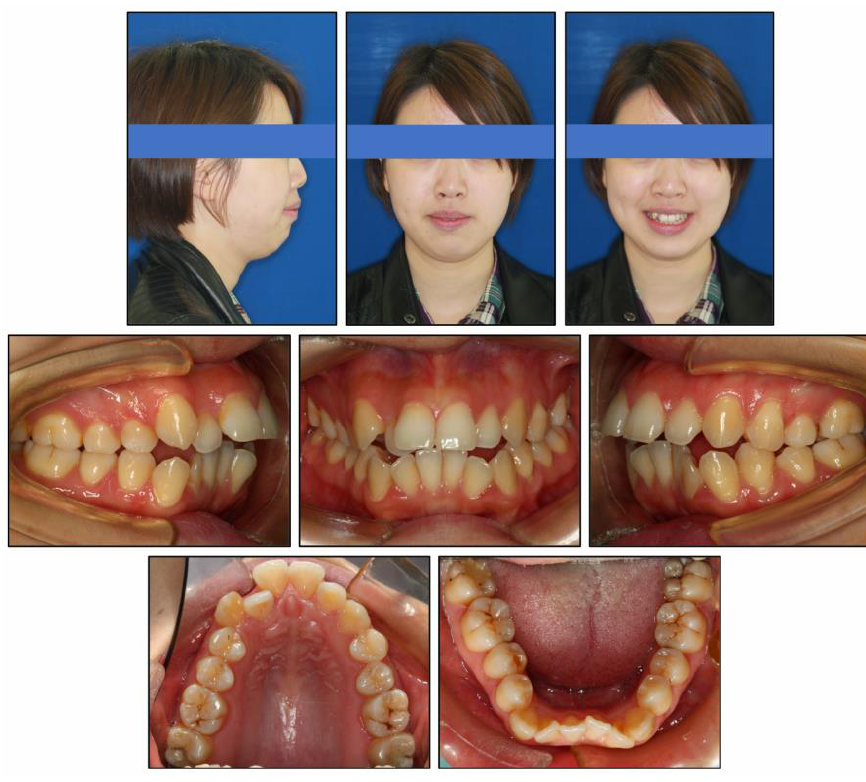
Figure 1. Pretreatment intraoral and facial photographs.